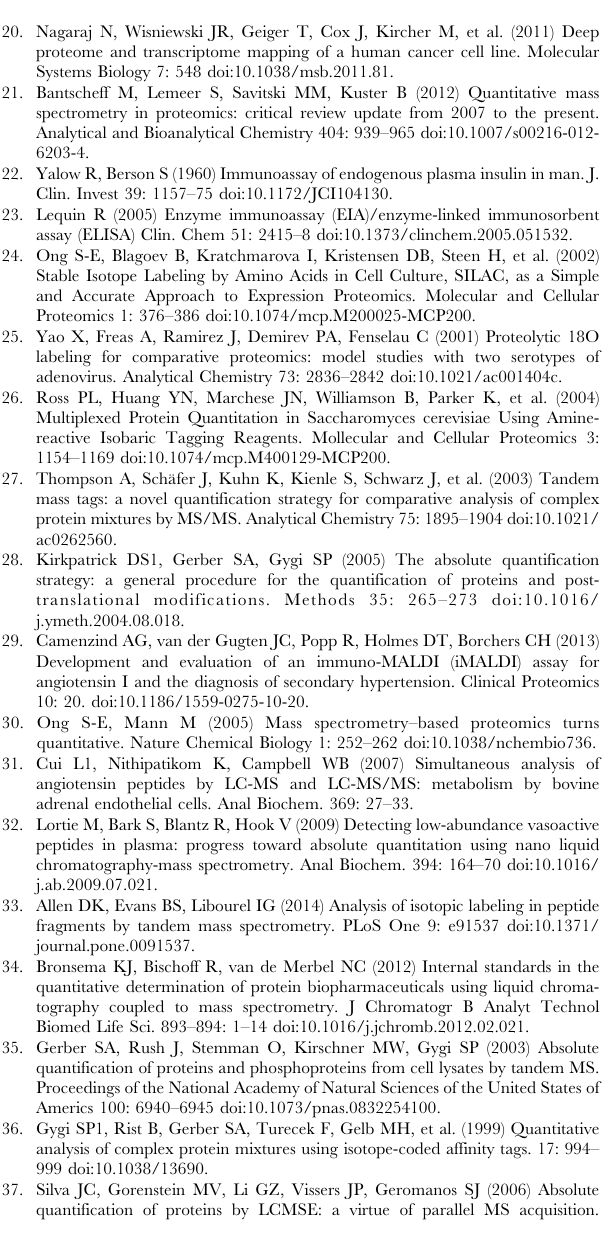
tions. Table S2 Contains the raw fit results from the GMM analysis of data in materials S2 (convolved peptide data). (CSV) Material S1 Single peptide spectra data. (CSV) Material S2 Convolved peptide spectra data.